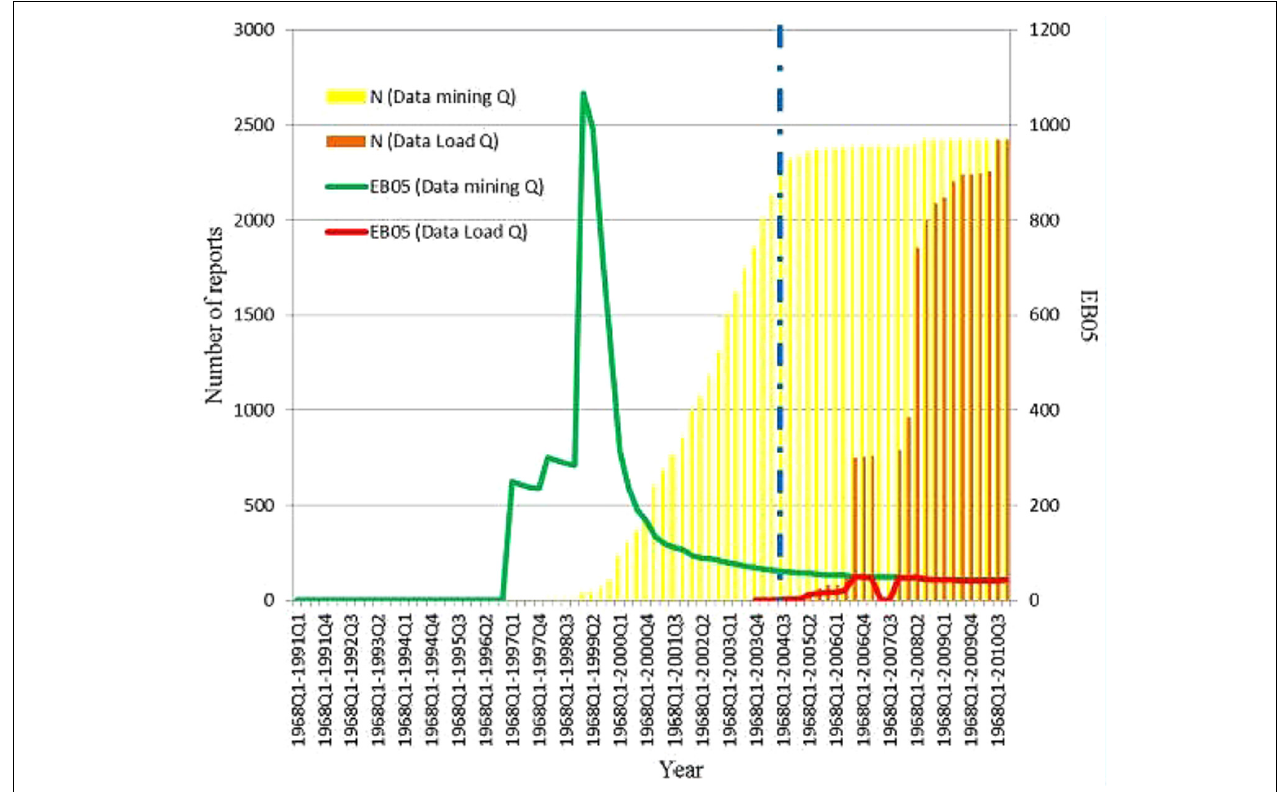
FIGURE 5 | Acute myocardial infarction and Rofecoxib in WHO-VigiBase database. The yellow bars in the figure show the number of cumulative reports by quarter using the data mining quarter date. The orange bats represent the cumulative reports by the date they were reported and entered into WHO-VigiBase. The vertical blue line marks the date the manufacturer withdraw the product. The EBOS values using the data mining quarter is shown in greenline and using the data load quarter is shown in red